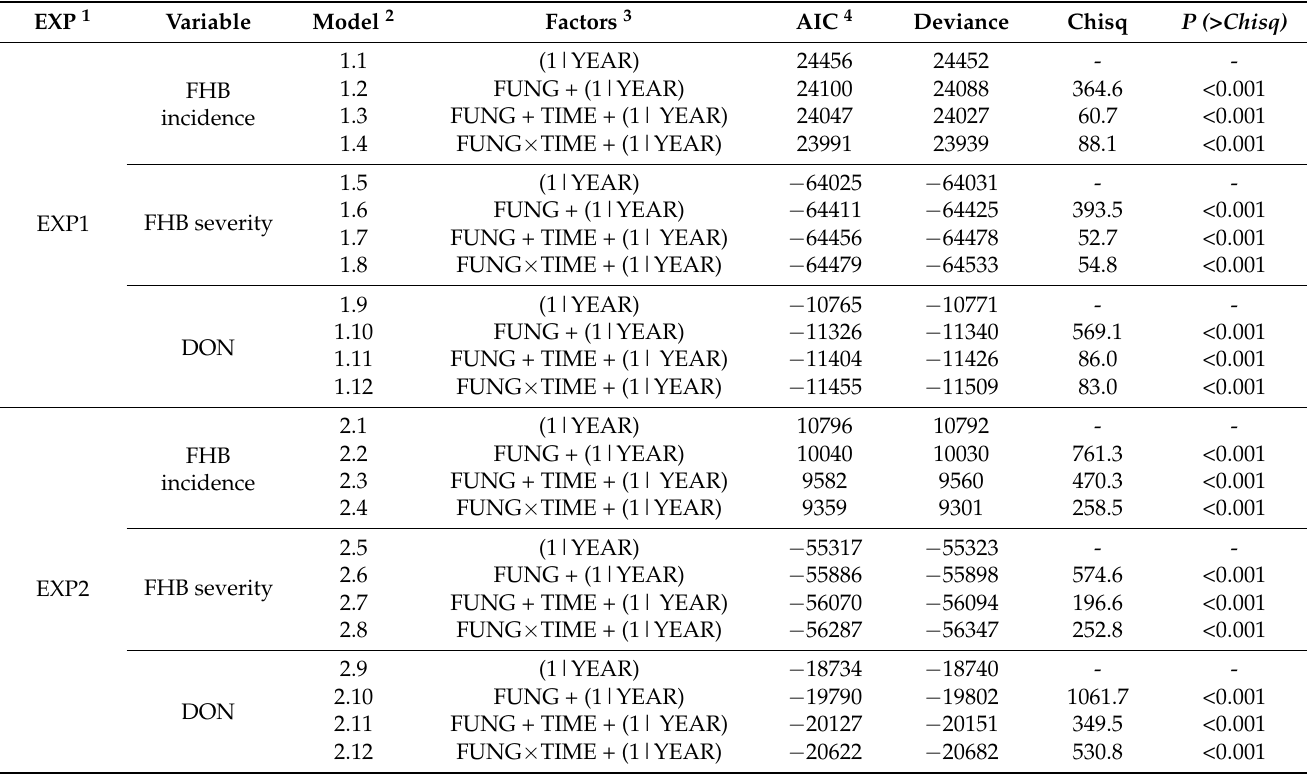
Table 3. Generalized linear mixed models fit to the data from the experiments carried out at Ravenna, North Italy, for the control of Fusarium head blight with different fungicides applied based on wheat growth stages (EXP1) and on days before or after artificial inoculation of wheat spikes with Fusarium graminearum